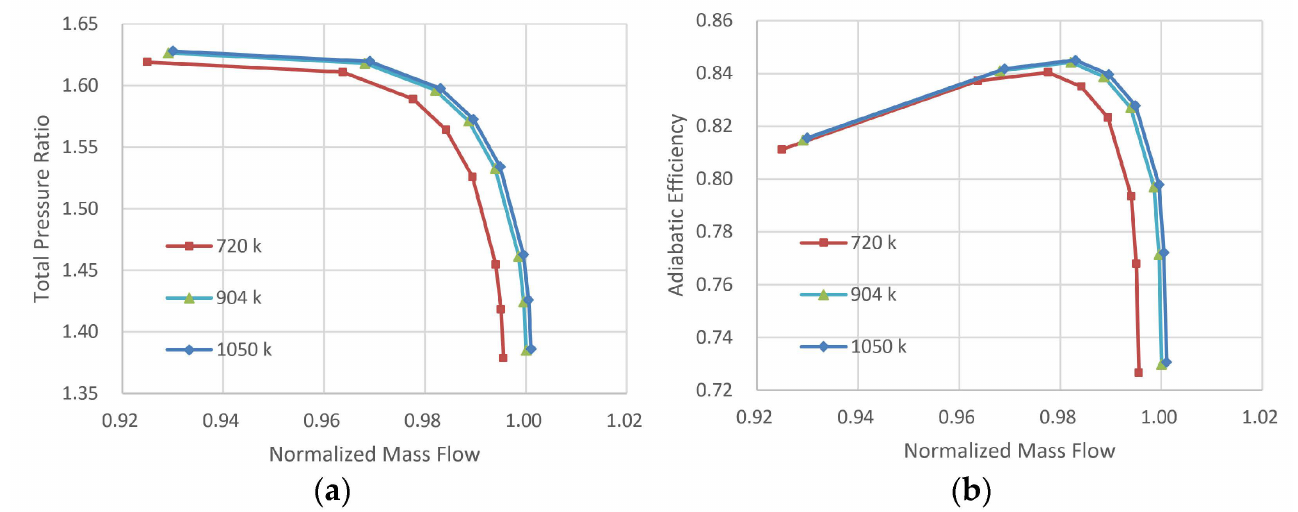
Figure 7. Comparison of the 11D compressor performance parameters obtained from different grids with the same single passage 3D CFD scheme: ( a ) mass flow versus total pressure ratio, and ( b ) mass flow versus adiabatic